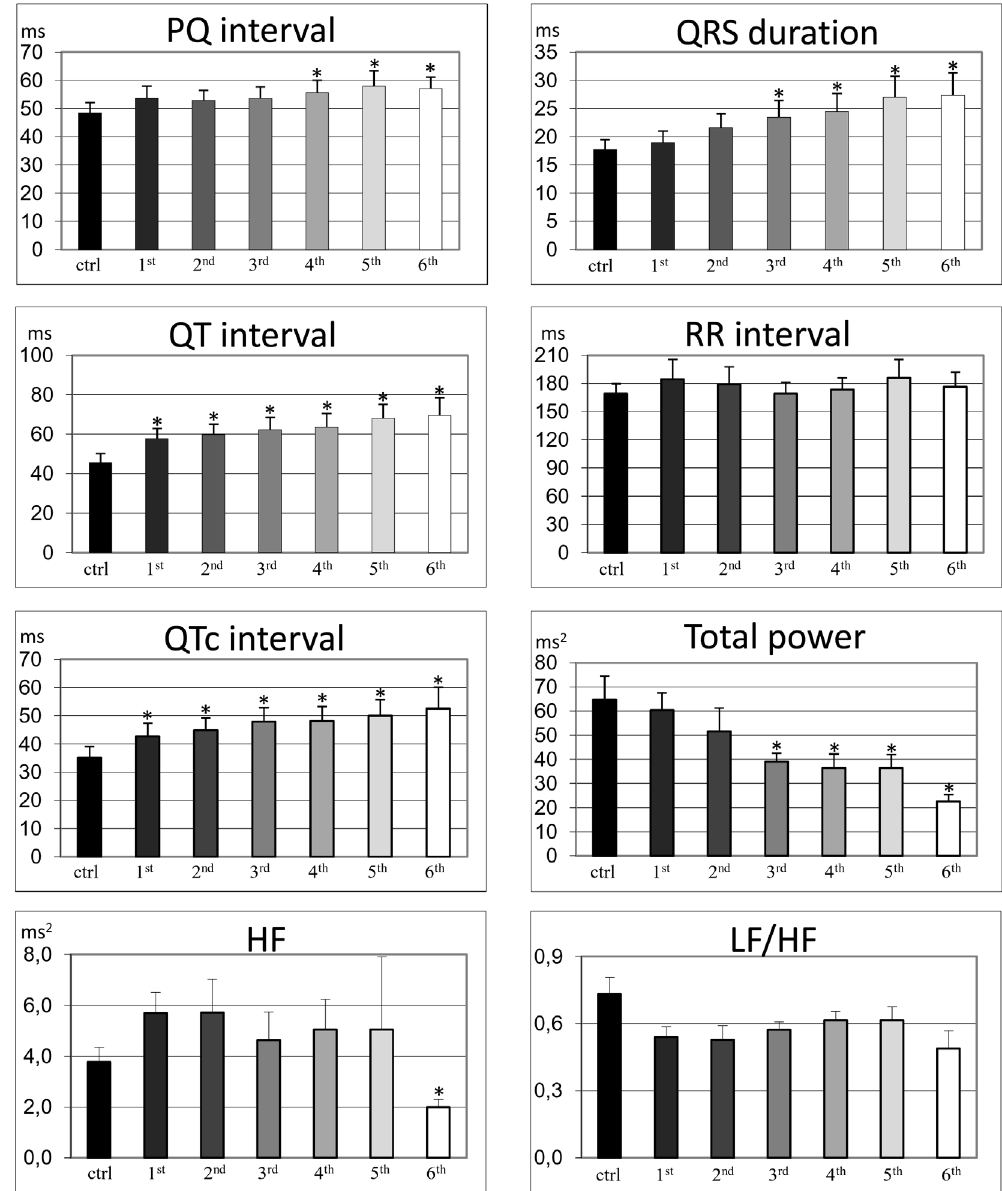
Figure 2. Telemetry ECG time and frequency domain analysis. Histograms of telemetry ECG basic electrophysiological parameters and frequency domain indexes of simpathovagal balance, evaluated from the 1 st to the 6 th month after radiotelemetry transmitter implantation of all animals. HF: High Frequency. LF: Low Frequency. * p , 0.01 compared with control (ctrl).